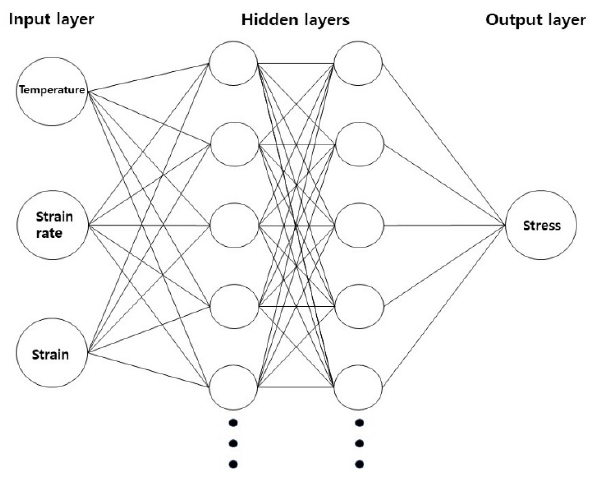
Figure 4. Structure of neural network.